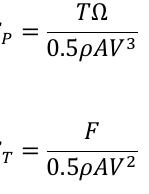
Figure 16. Thrust comparison between BEMT calculations and experimental data for inflow profiles with and without a turbine when the turbine operates under wave-current interactions with a wave height of approximately 0.19m and an apparent wave period of 0.7s.